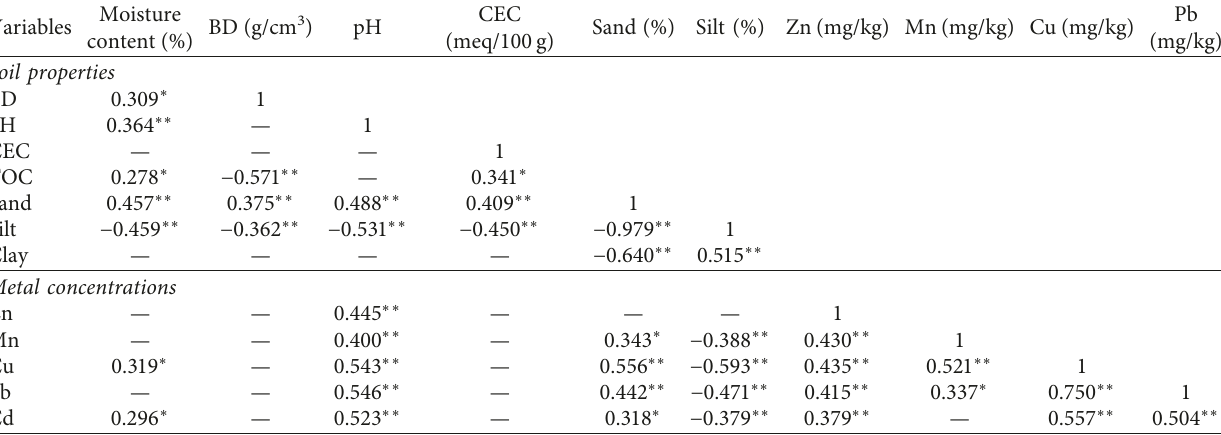
Table 3: Spearman’s rho correlation coefficients for soil properties and PTM concentrations ( n � 52). Significant correlations are marked with ∗ ( p < 0 . 05 ) or ∗∗ ( p < 0 . 01 ) .